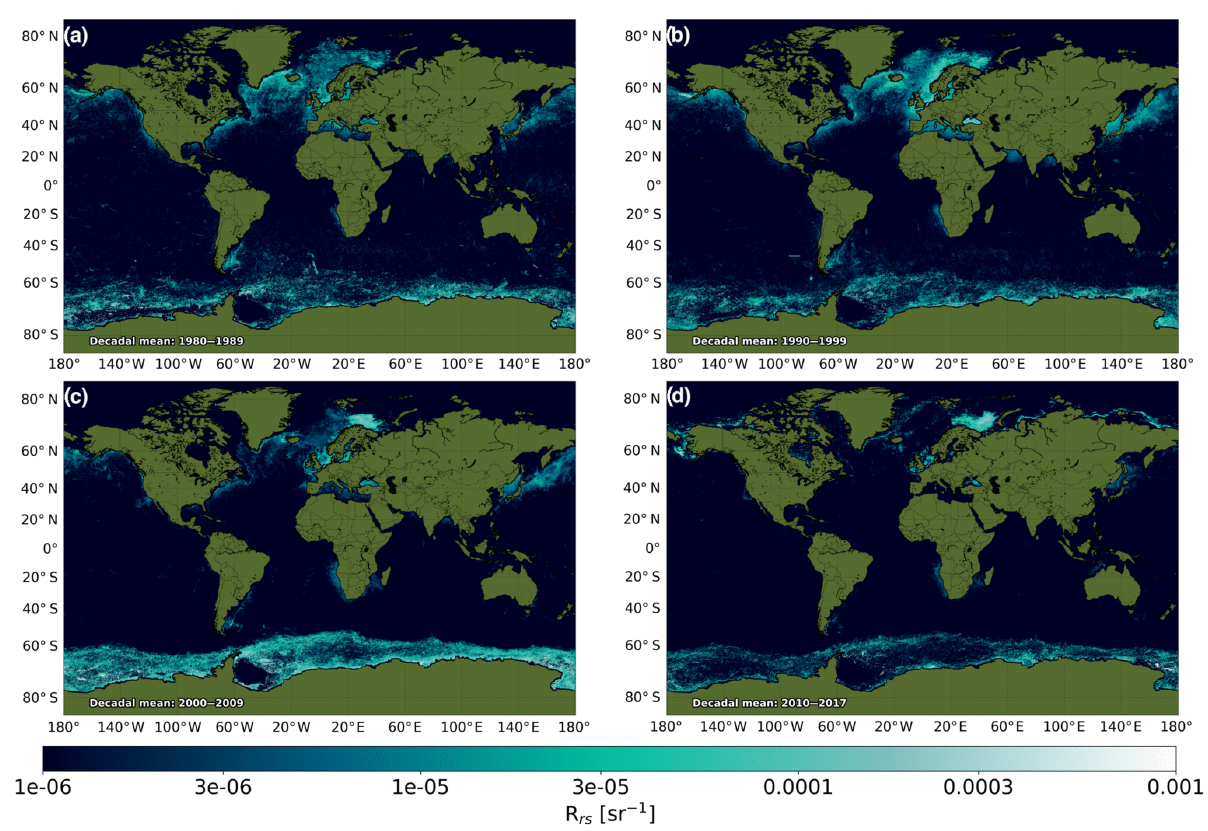
Figure 4. Mean values for the filtered remote-sensing reflectance ( R rs ) bloom product by decade for the (a) 1980 to 1989, (b)